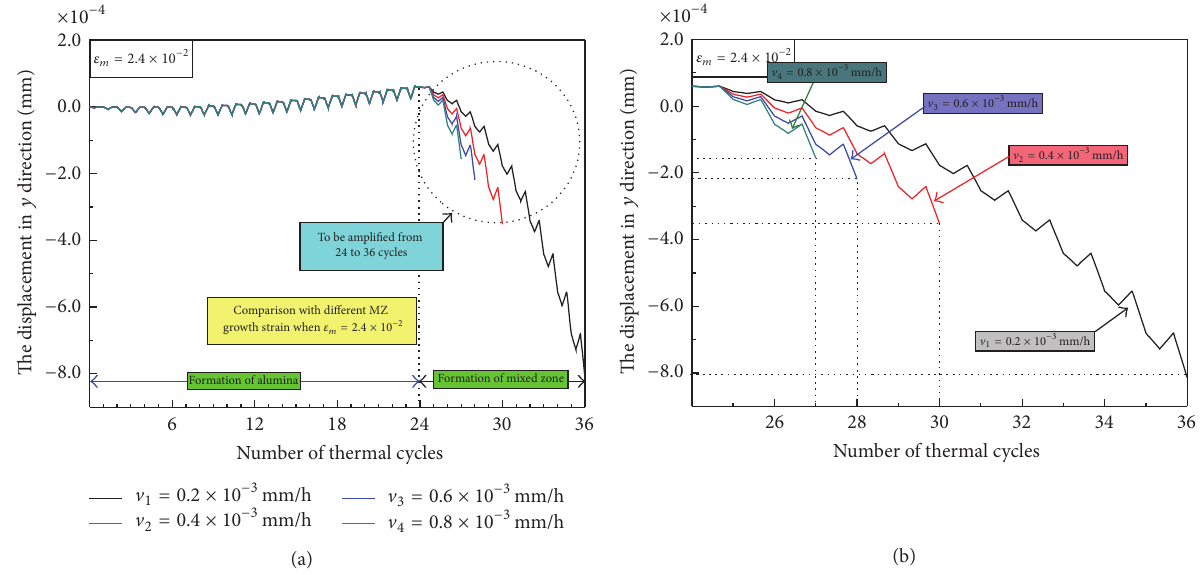
Figure 4: (a) The plot of displacement in 𝑦 direction for node number 517 at the base of the surface groove against the number of thermal cycles when 𝜀 𝑚 = 2.4 × 10 −2 . (b) The details for the variation of displacement for the formation of MZ.